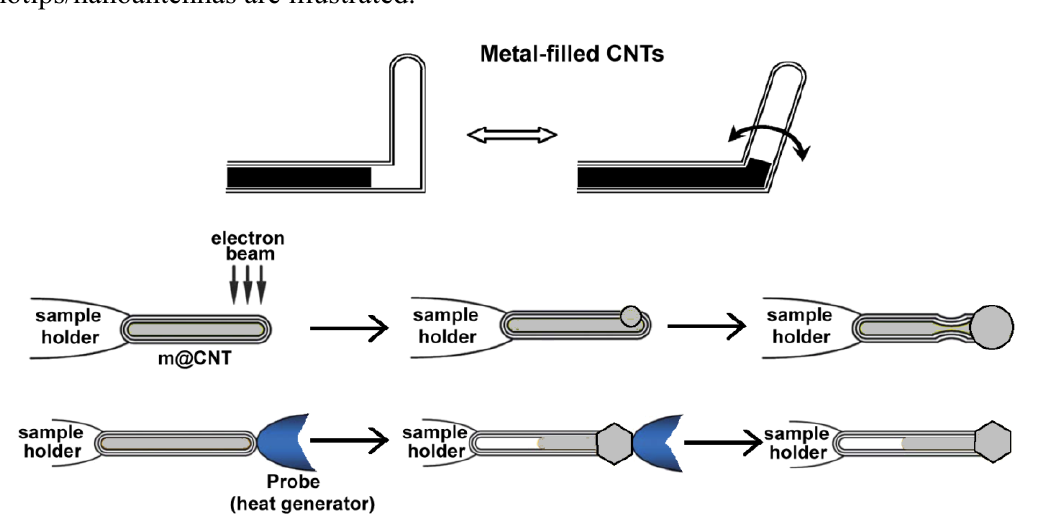
Figure 1. CNTs filled with metals. Two methods for bubbling metals from the nanotubes (electron beam focusing and heat generation) in order to obtain